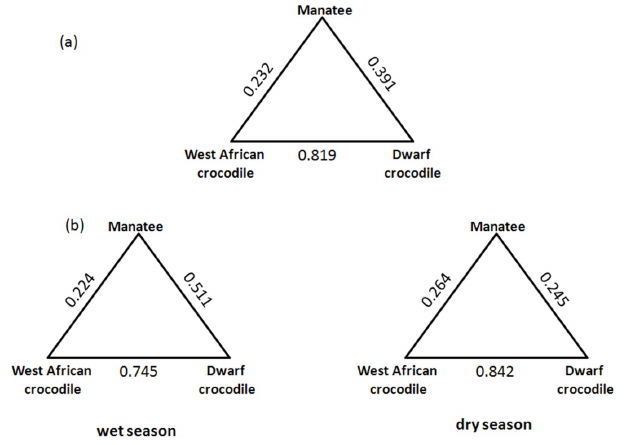
Figure 4. Macro-habitat niche overlap values between crocodiles and manatee at the study area. (a) seasons pooled; (b) seasons sep-